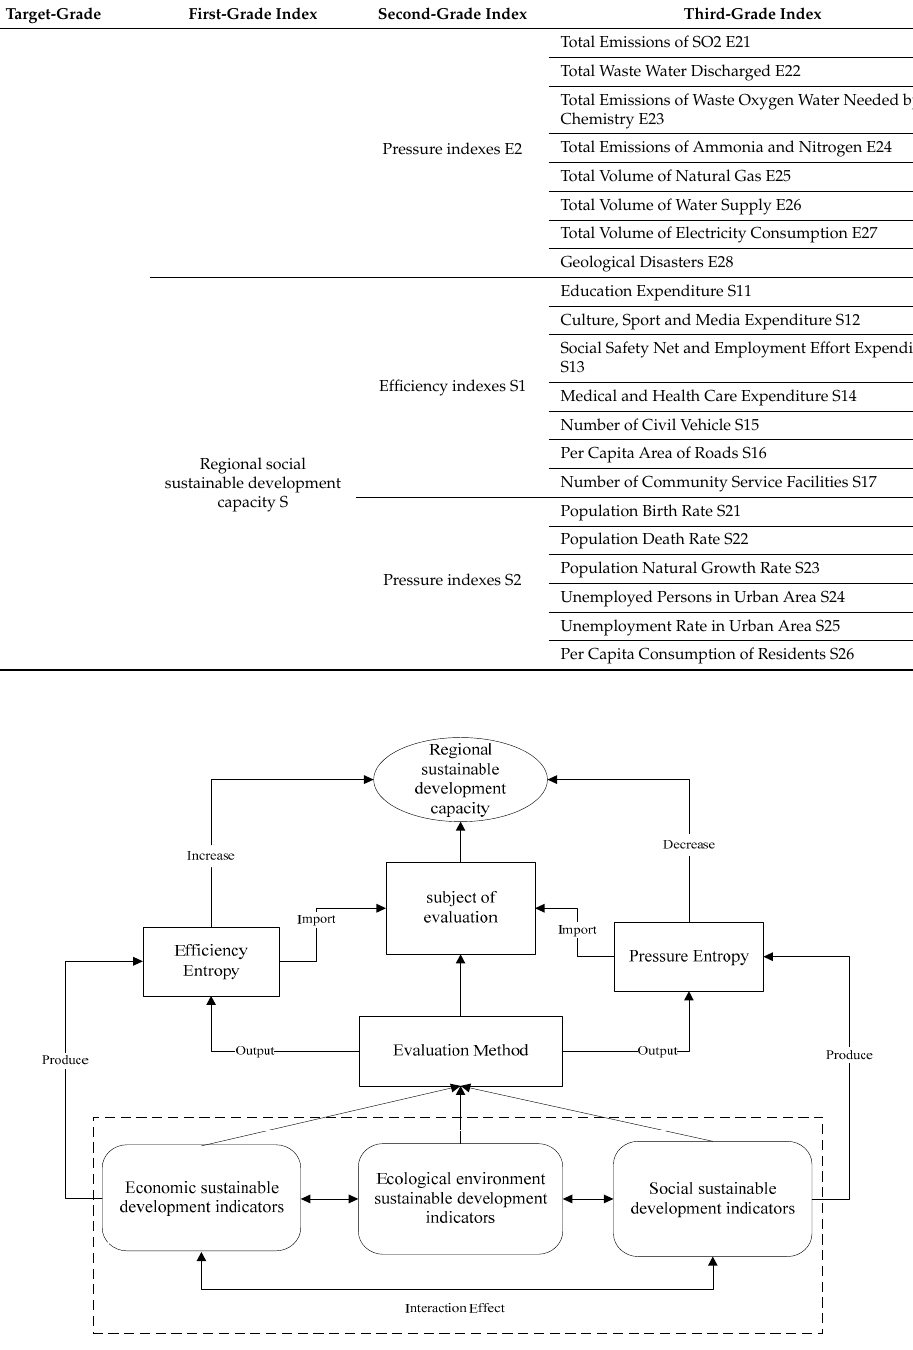
Figure 1. Index support figure.